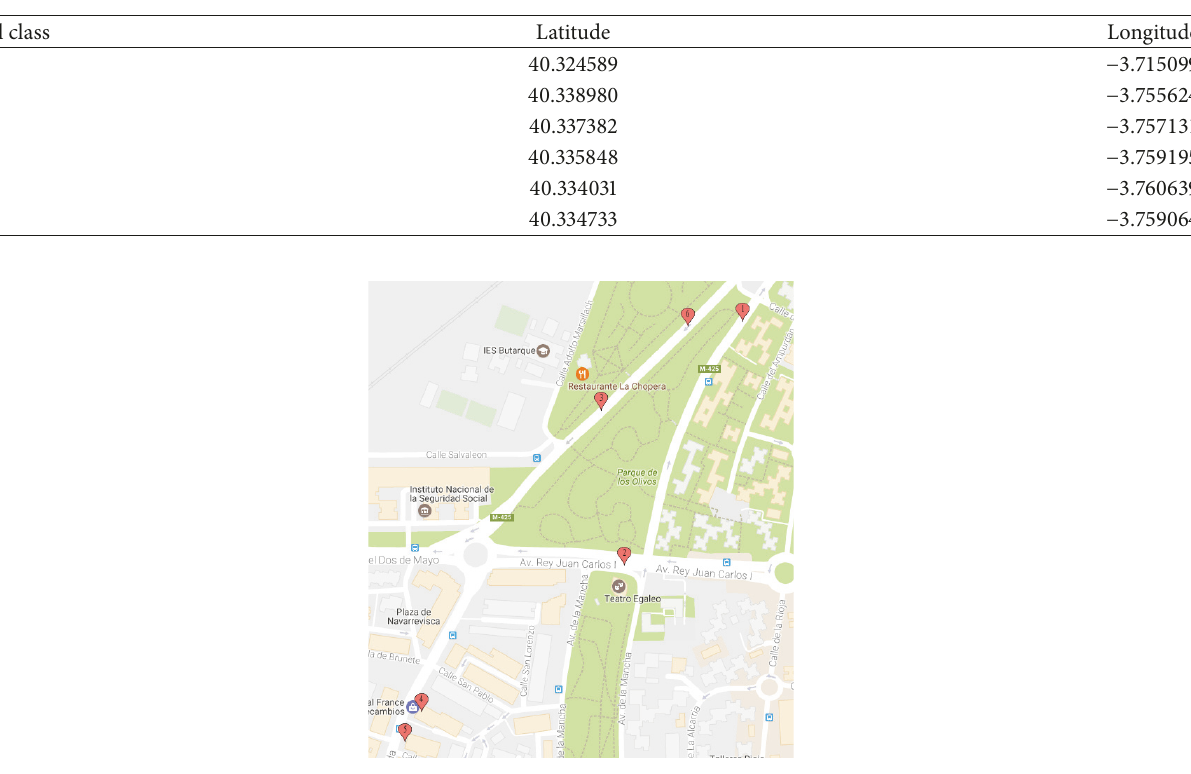
Figure 4: Traffic lights